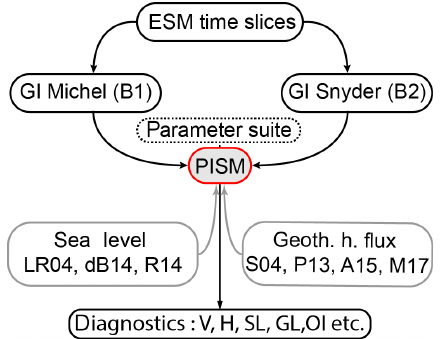
Figure 3. Schematic flow chart of the model ensemble. The ice- sheet model (PISM) is forced via the transient forcing derived by linear interpolation with glacial indices from Michel et al. (2016) and Snyder (2016) forming ensemble branch B1 and B2. Prescribed input data consist of sea level (SL) data and geothermal-heat-flux (GHF) data sets. Both ensemble B1 and B2 are constructed with 12 different forcing combinations (three SL data sets and four geothermal-heat-flux fields). The parameter suite is derived from sensitivity studies in which the present-day Antarctic Ice Sheet and its sea level contribution during the last two glacial cycles were the main tuning targets.